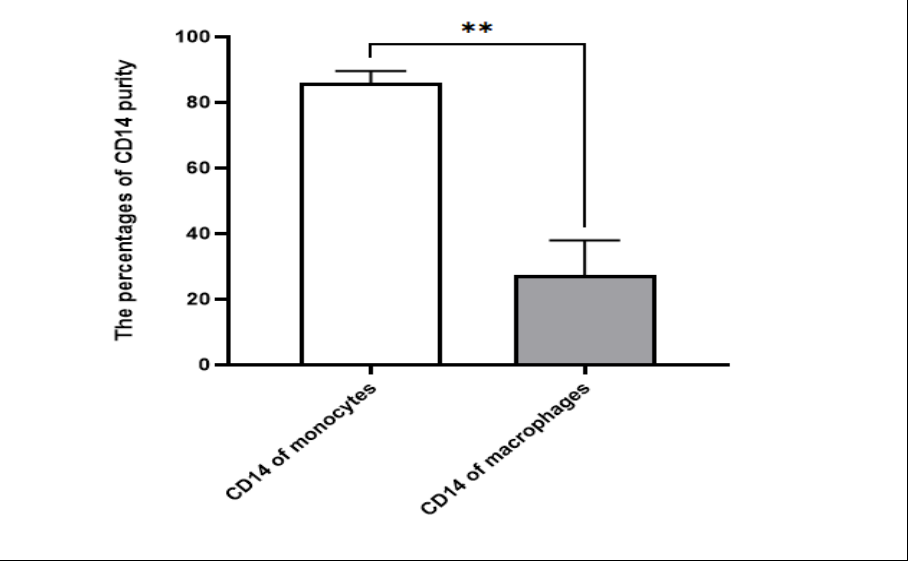
Figure 3. Comparison between the expression of CD14 on isolated monocytes and differentiated macrophages. The expression of CD14 cell ‐ surface molecules decreased on differentiated macrophages after 7 days of culturing negatively selected monocytes, indicating the full conversion of monocytes to macrophages. n = 5. ** p value ≤ 0.01.